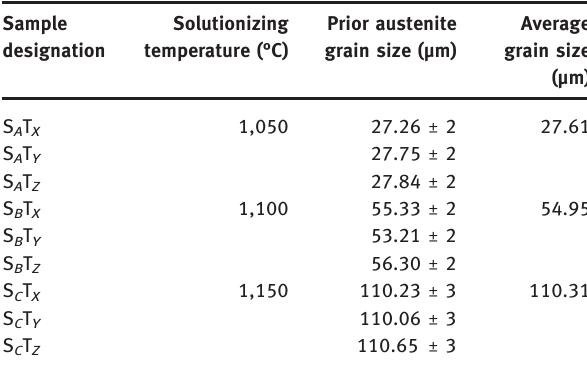
Table 3: Prior austenite grain size for each heat-treated condition.